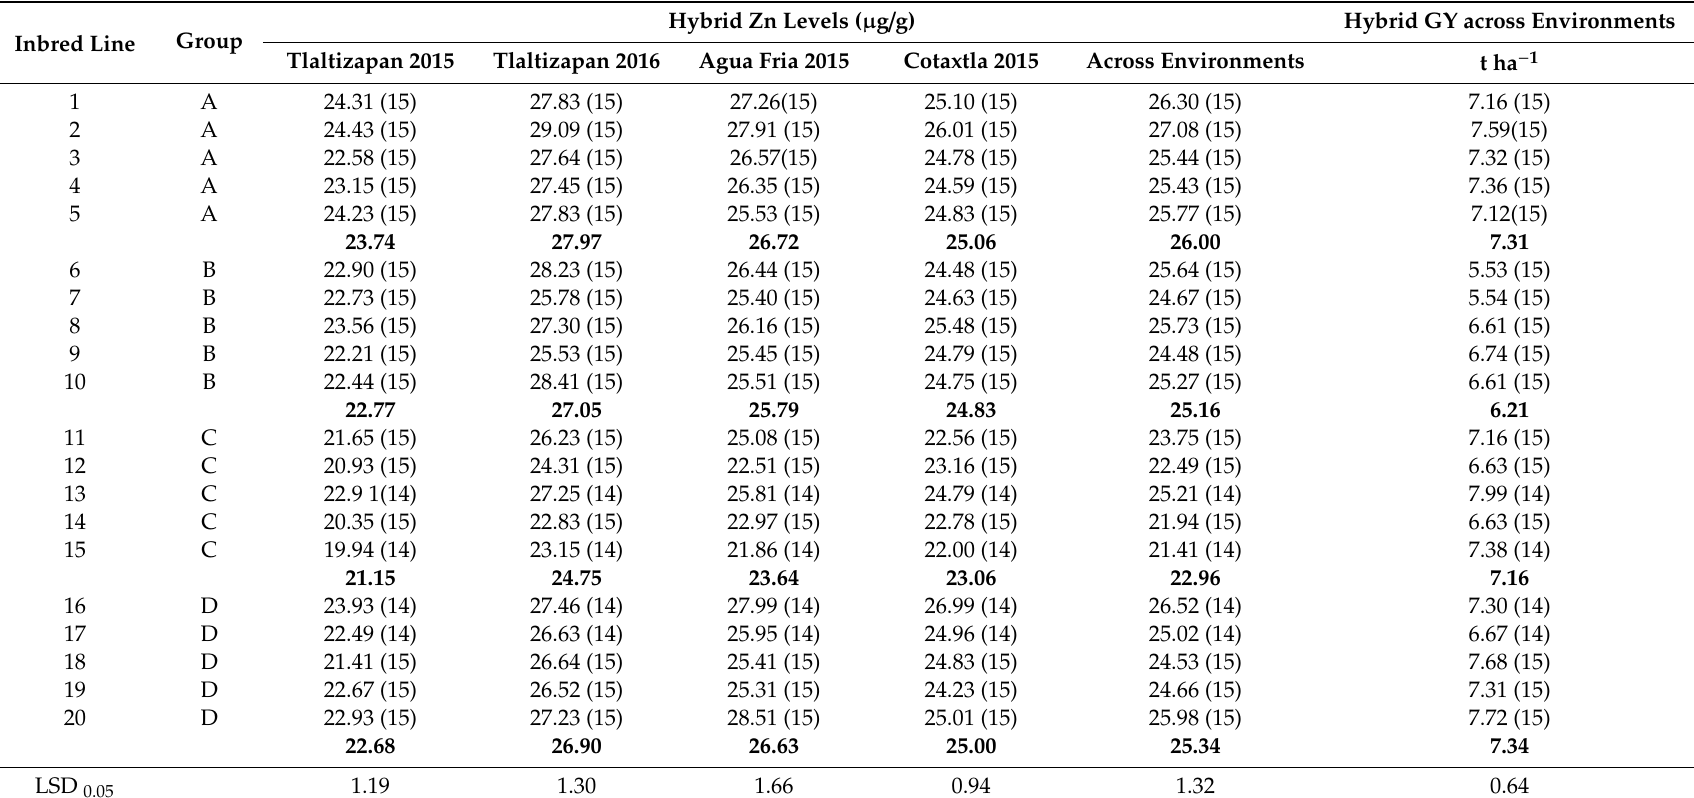
Table 3. Average kernel Zn and grain yield for inbred lines as observed in hybrid